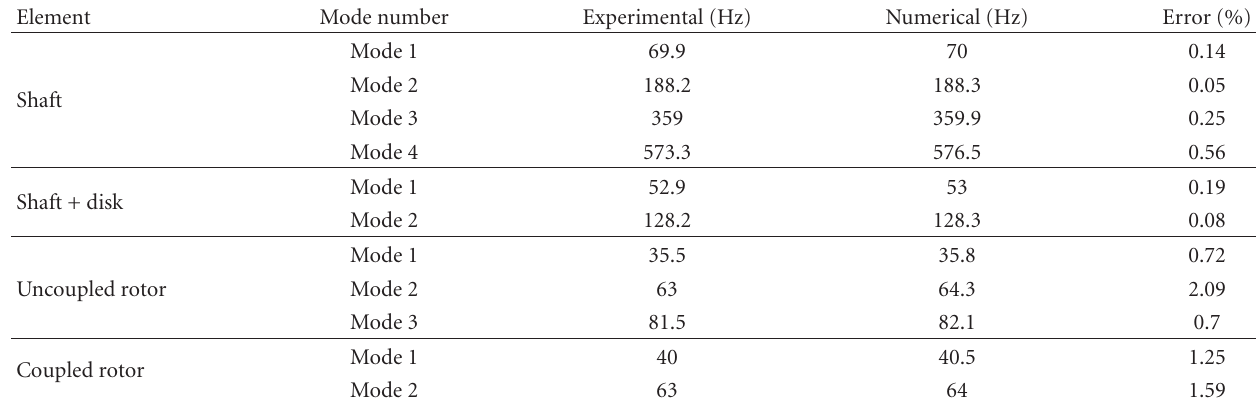
Table 3: Experimental and numerical results.